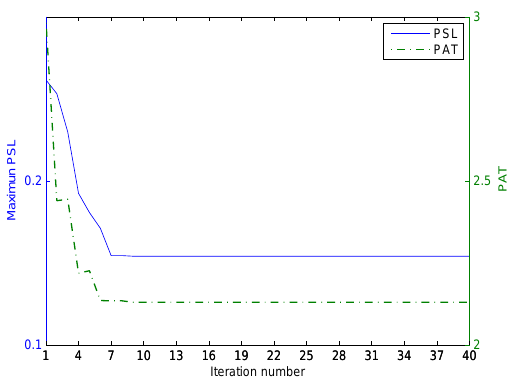
Figure 15. The iterative process of optimization in the first stage for the